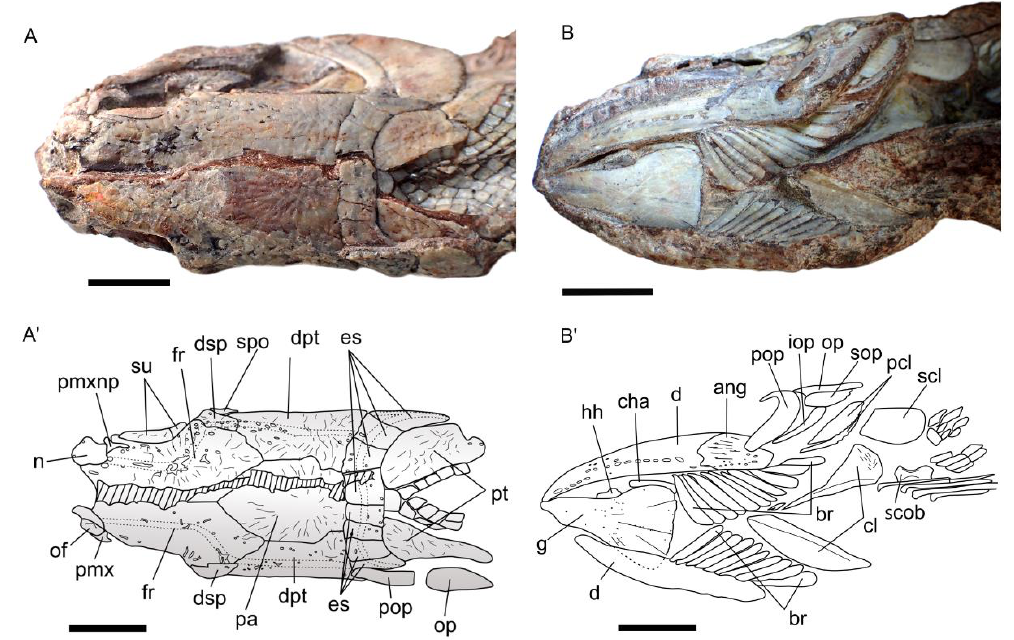
Figure 3. Khoratamia phattharajani gen. et sp. nov., holotype NRRU-F01020023, skull roof in dorsal view: ( A ) interpretative line drawing ( A’ ) and ventral view ( B ) interpretative line drawing ( B’ ). Scales bars: 1 cm.